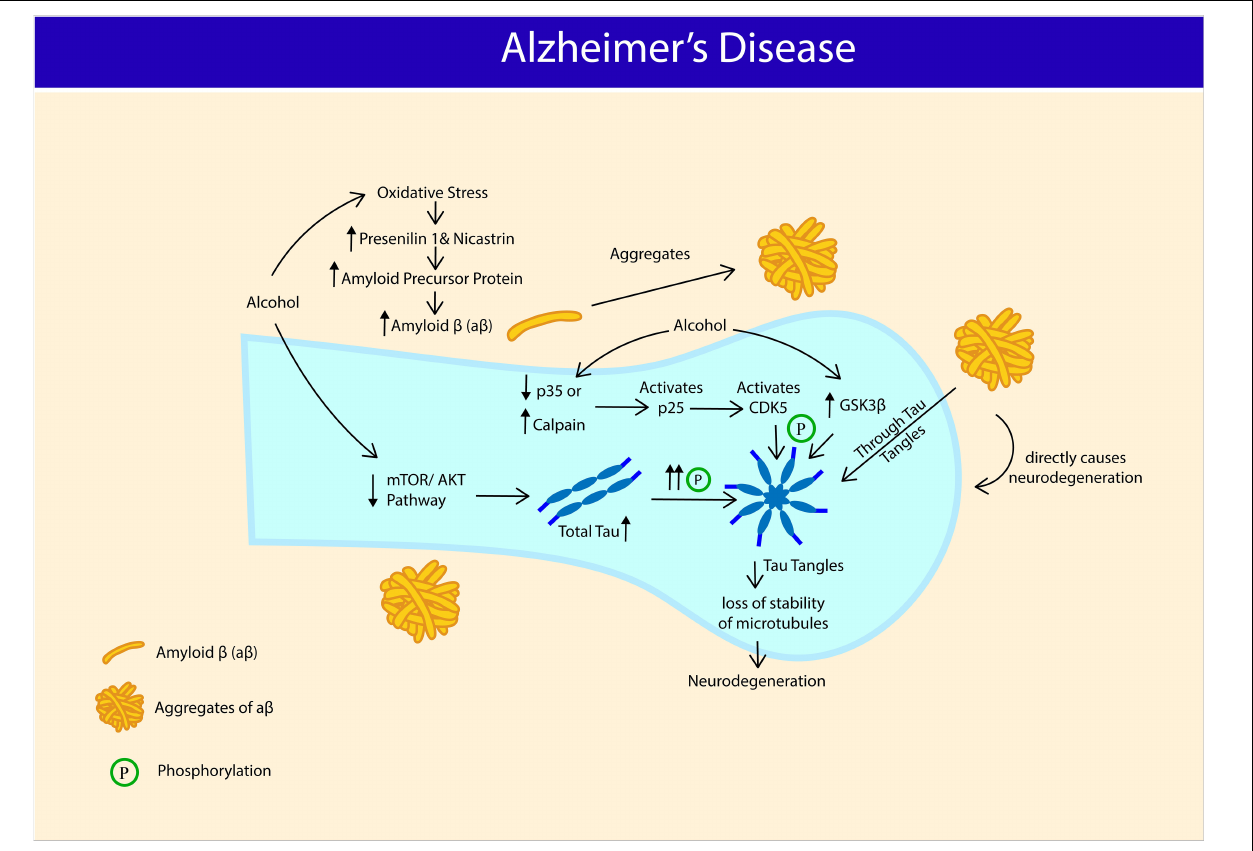
FIGURE 3 | Potential association between Alcohol Use Disorder and manifestation of Alzheimer’s disease (AD). Chronic alcohol intake triggers oxidative stress, increases amyloid precursor protein (APP), presenilin (PS1) and nicastrin expression that serves as a basis for amyloid β (a β ) production and a β aggregates. Chronic alcohol intake reduces phosphorylation of proteins associated with mTOR/AKT pathway and increases total tau expression. Chronic alcohol activates CDK5 and Glycogen synthase kinase-3 β (GSK3 β ) and hyperphosphorylates Tau protein into Tau tangles. Aggregates of a β directly causes neurodenegeration and also through tau tangles. Hyperphosphorylation of tau proteins results in loss of microtubule stability, causing